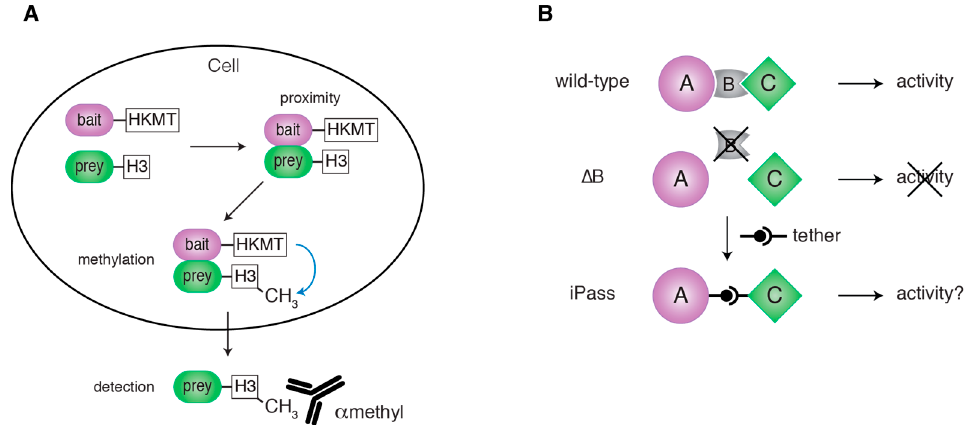
Figure 6. In vivo assays to monitor individual steps during a signaling pathway. ( A ) The protein proximity assay M-Track. A bait protein is tagged with a histone lysine methyltransferase (HKMT) and a prey protein with a fragment of histone H3 (H3). Close proximity between bait and prey leads to the methylation of the H3 tag by HKMT. This methylation mark is detected by Western blotting using an antibody specific for H3 lysine methylation. ( B ) iPass (induced bypass). When the bridging factor B of a trimeric complex (A-B-C) is deleted, the function of the complex is lost. In iPass, A and C are inducibly tethered in the absence of B. iPass restores the activity of the complex if the only non-redundant role of B is to link A and C. iPass can be used to study the function of B or to temporally control the progression of the pathway governed by the complex A-B-C—see text for details.